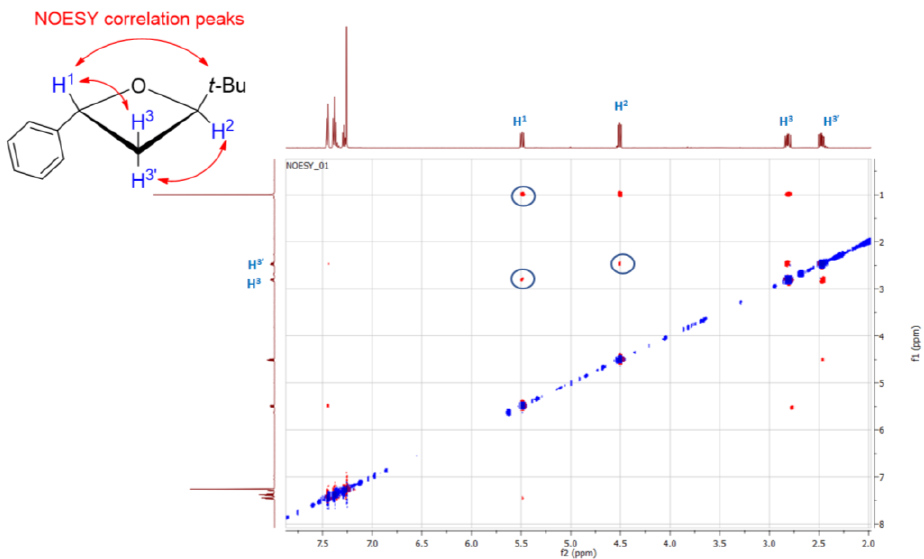
Figure 1. 2D-NOESY NMR spectrum, CDCl 3 , trans -2-( tert -butyl)-4-phenyloxetane ( 5 ): selected NOE interactions.